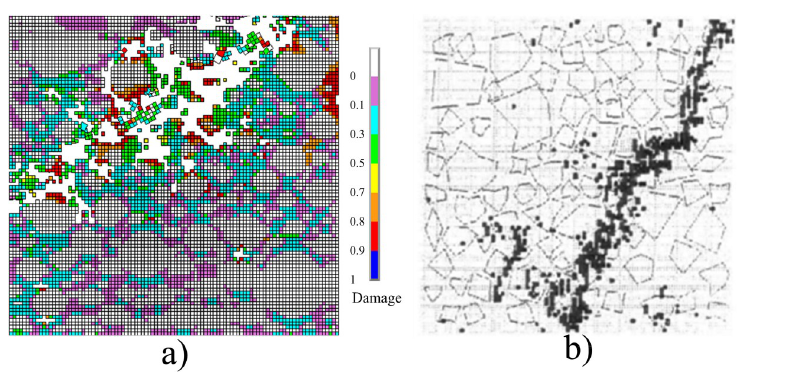
Fig 13. Failure mode of concrete under uniaxial compression. a) The numerical result obtained from the model in Fig 9. b) The result given in the literature [33].